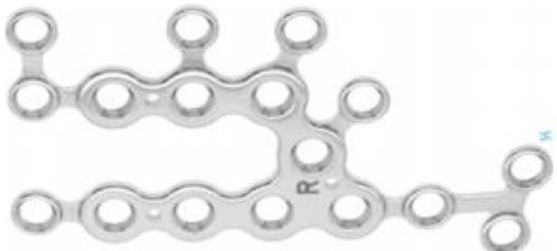
Figure 3. Internal fixator–plate for treatment of heel bone fracture (alternative method of treatment).